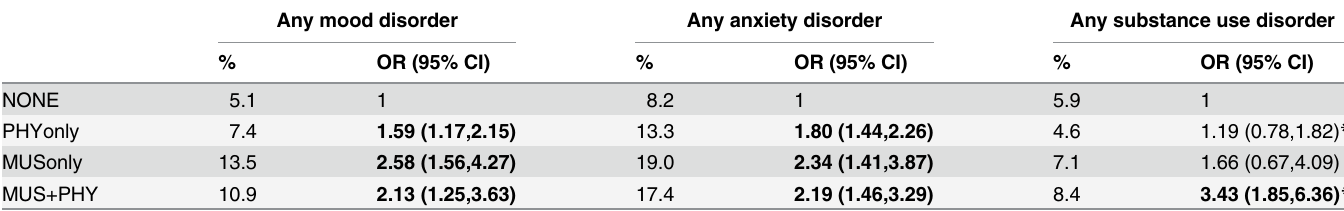
Table 3. 12-month prevalence of (comorbid) common mental disorders (n = 6,506). Any mood disorder Any anxiety disorder